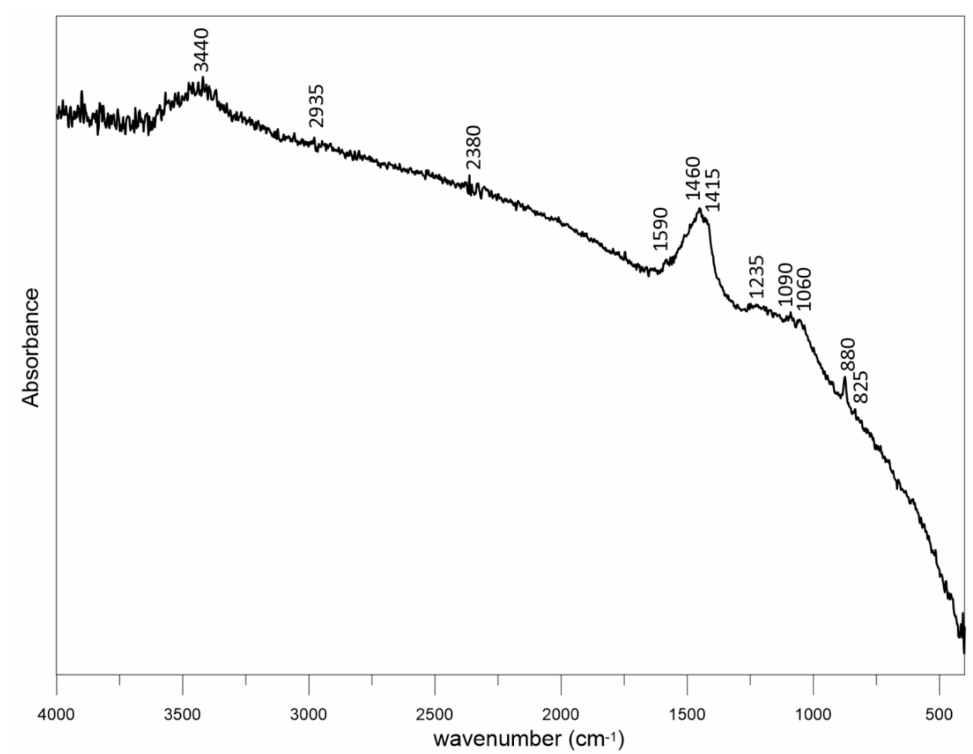
Figure 2. The FT-IR spectra of dry residue cavitated